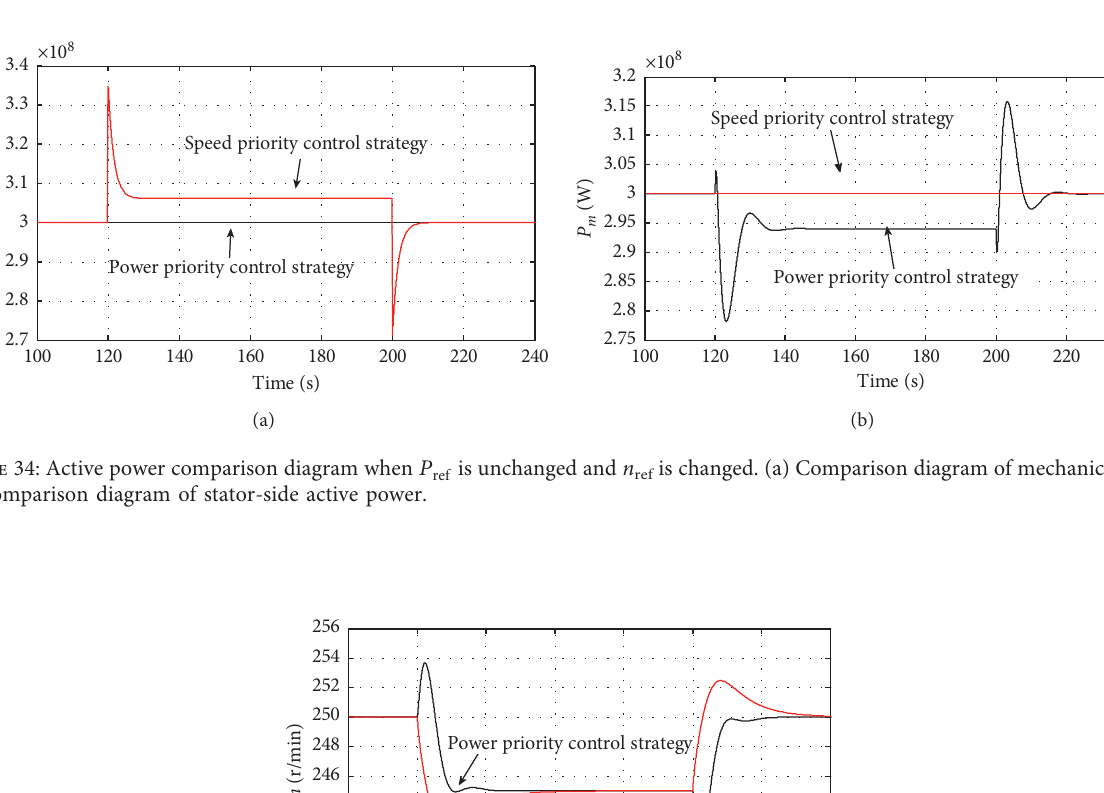
is unchanged and n ref is changed. ref